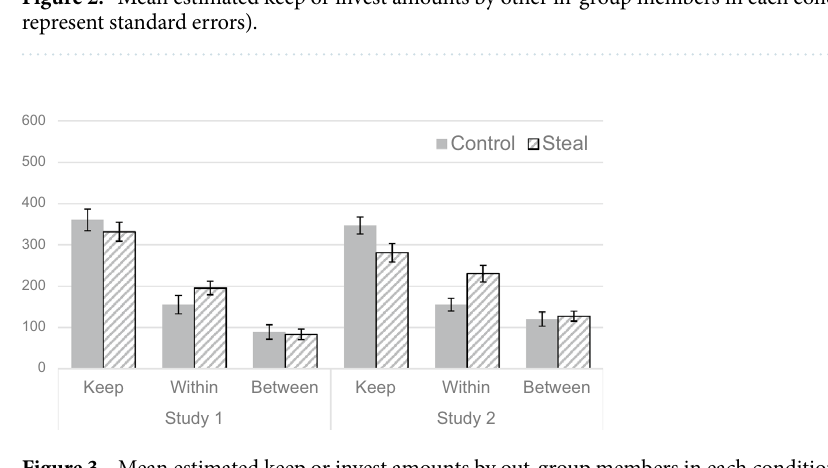
Figure 3. Mean estimated keep or invest amounts by out-group members in each condition (error bars represent standard